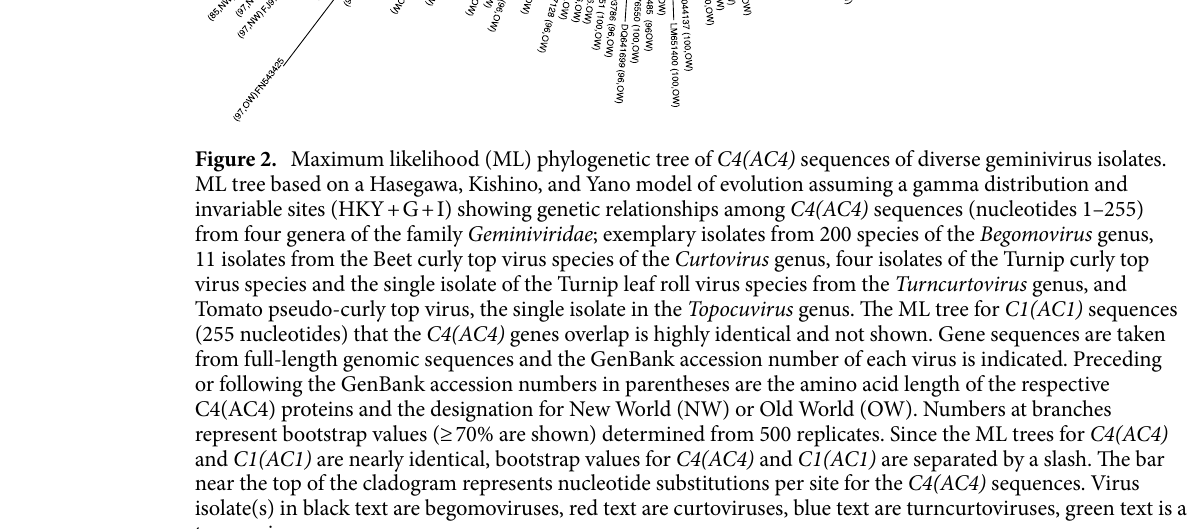
displayed an α-value of 1.57. An α > 1 with a high relative substitution rate compared to the other positions indicates that C4(AC4)-2/C1(AC1)-3 positions have intermediate substitution rates, while a few codons have very high or very low relative substitution rates 50 . The high substitution rate and infinitely large α-value for the